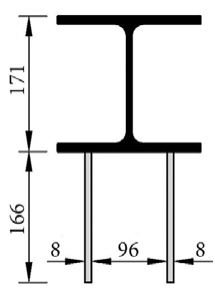
Fig. 22. Joint cross-sections: C1-C1 and C3-C3 (HEA180 and twin gusset